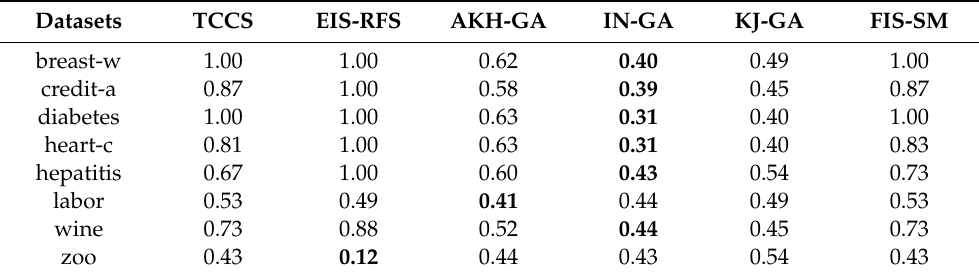
Table 13. Feature retention results of the algorithms.